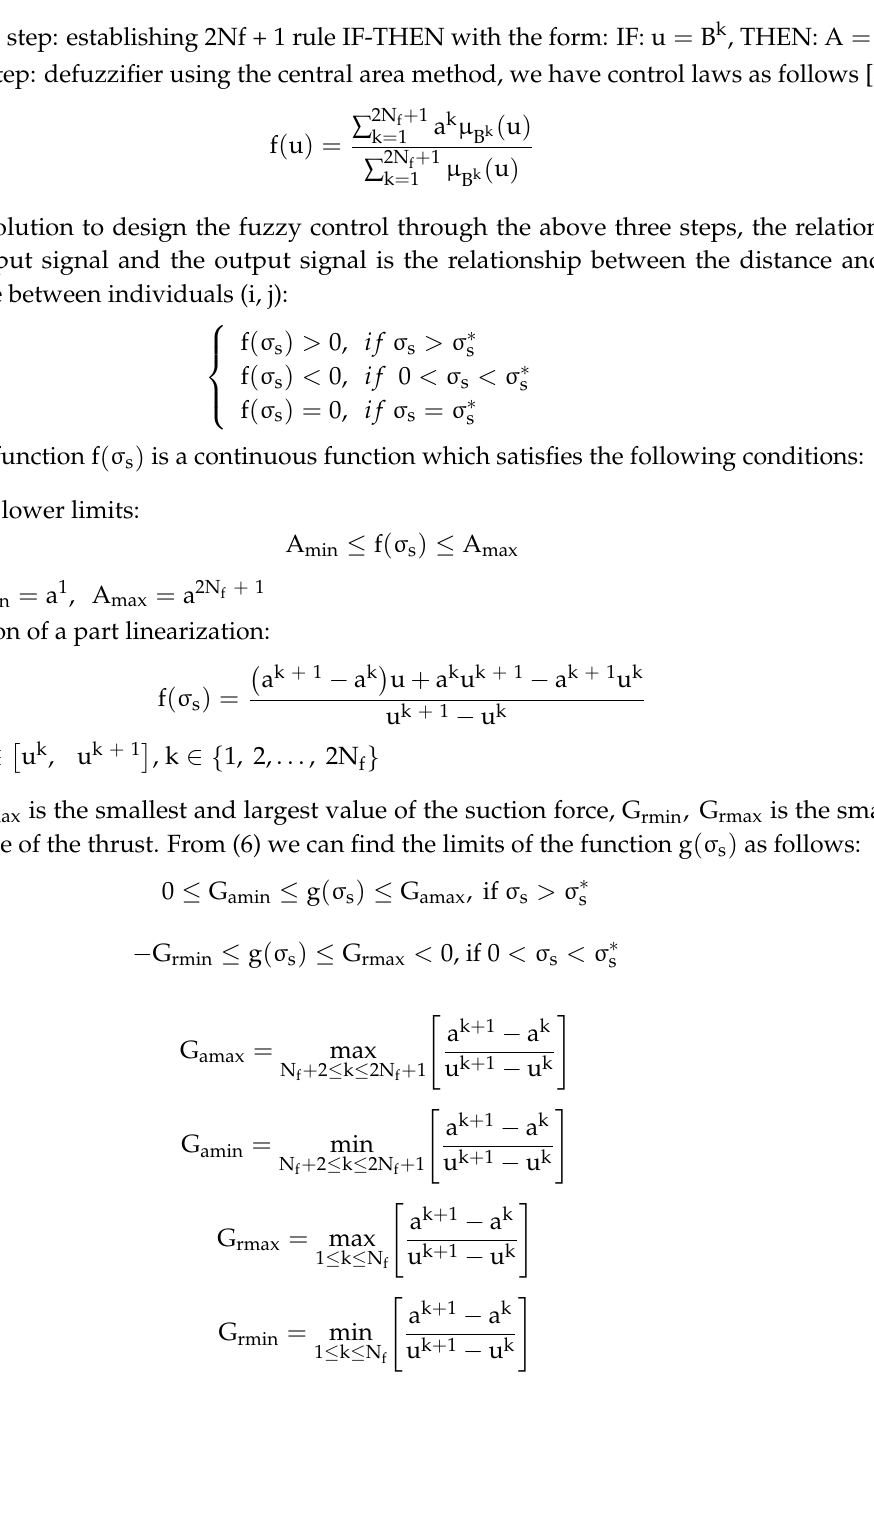
Figure 2. The membership function of the output.